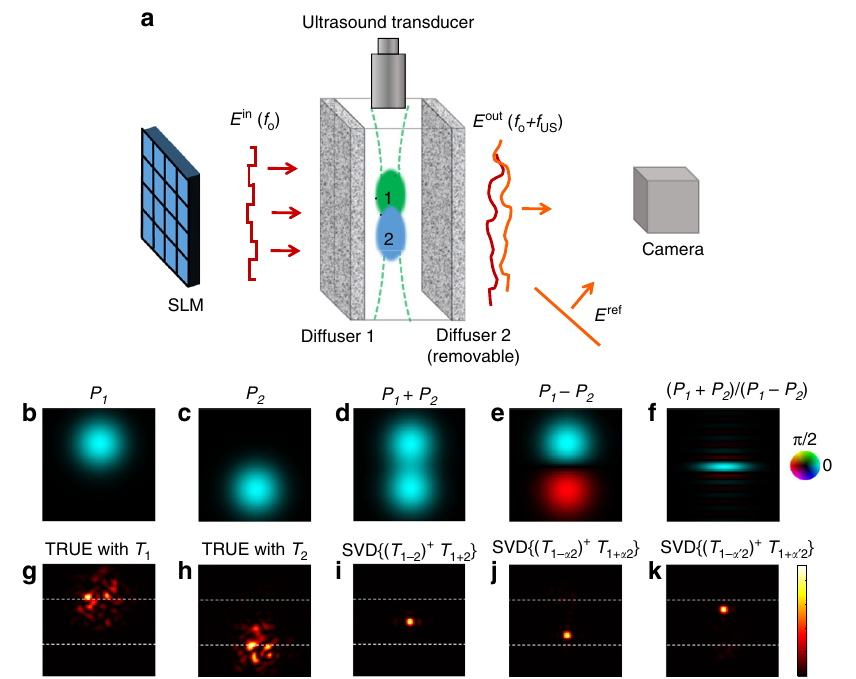
Fig. 3 Simulations of focus scanning using two acousto-optic transmission matrices. a Measurement setup: two partly overlapping ultrasound foci (marked by “ 1 ” and “ 2 ” in green and blue, respectively) are used to measure two acousto-optic transmission matrices (AOTMs), T 1 and T 2 ; b , c ultrasound pressure amplitude distributions for the fi rst (P 1 ) and second (P 2 ) focus; d , e sum and differences of the ultrasound pressure fi elds; f sum of the pressure fi elds divided by the difference between the pressure fi elds, displaying a sharp peak between the two ultrasound foci centers; g – k optical intensity distributions at the ultrasound focal plane: for time reversal of ultrasound encoded light (TRUE) focusing using P 1 or P 2 ( g , h ), and focusing via singular value decomposition (SVD) of the matrix A α (Equation 3) formed by the weighted sum of T 1 + α T 2 divided by their weighted difference T 1 - α T 2 , for different values of α : α = 1 ( i ), α = 0.05 ( j ), and α = 20 ( k ). (Numerical simulations in the diffusive multiple-scattering light propagation